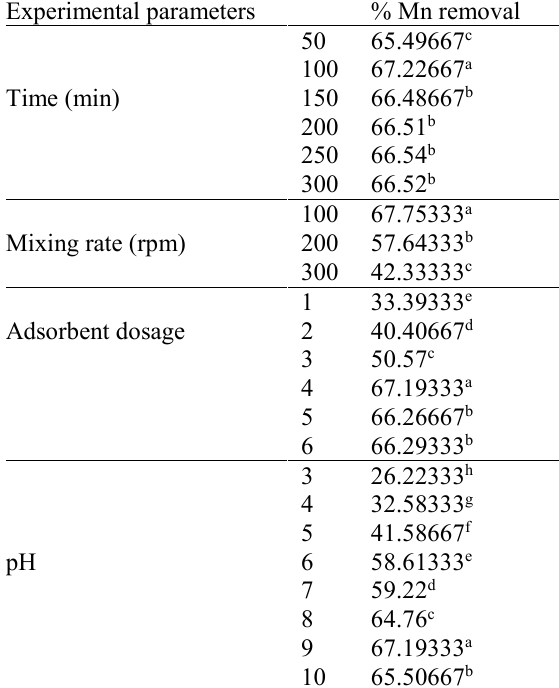
Table 1. Effect of experimental parameters on Mn